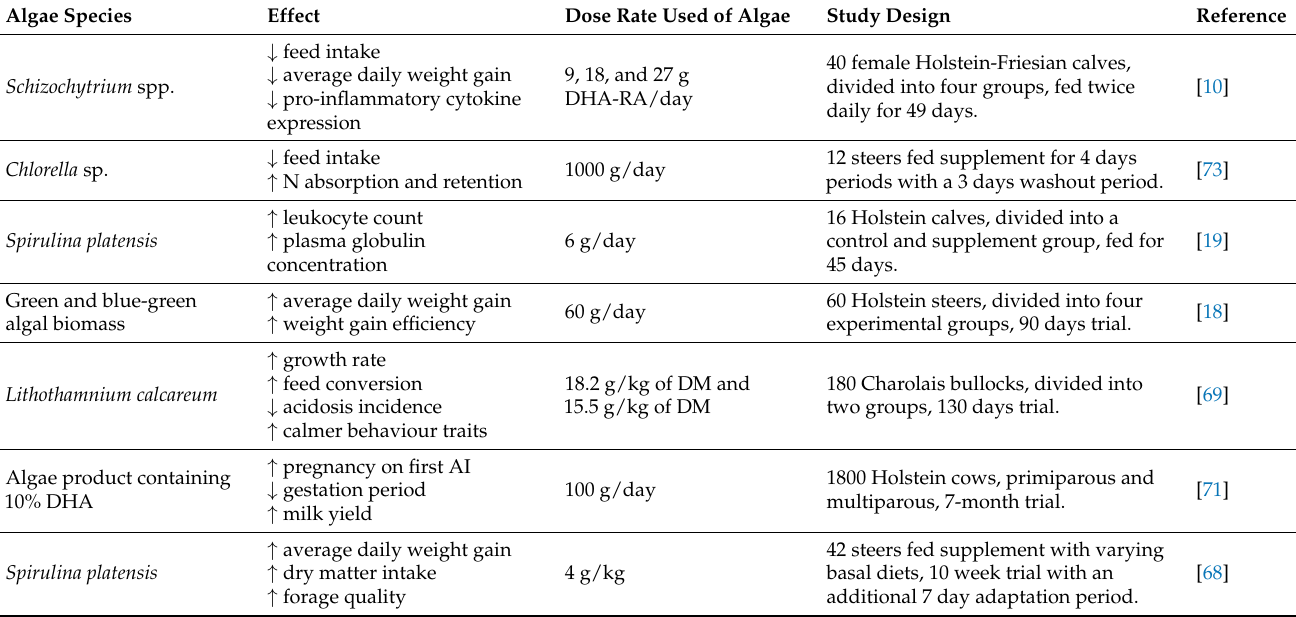
Table 2. Overview of the effects produced by different algae species in